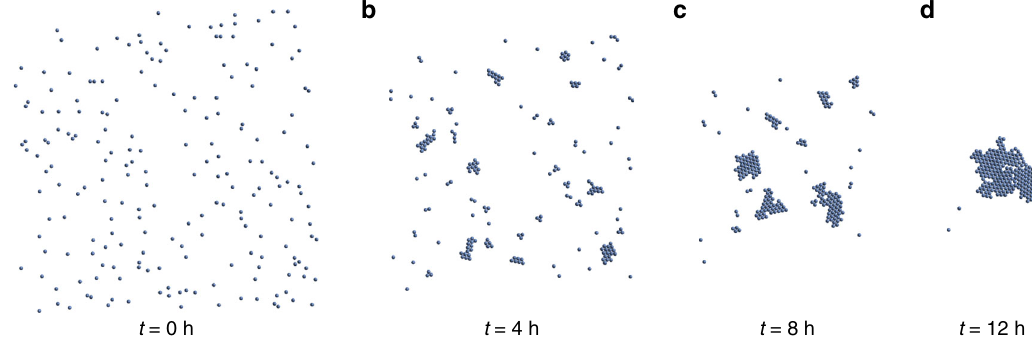
Fig. 6 Modi fi ed Stokesian dynamics simulation. Snapshots of many-body self-assembly and cluster formation at different times ( a 0 hrs, b 4 hrs, c 8 hrs, d 12 hrs), with a ¼ 0 : 045 cm, σ ¼ 0 : 03 g cm − 4 , μ ¼ 0 : 0113 Poise, κ ¼ 1 : 5 ´ 10 (cid:3) 5 cm 2 s − 1